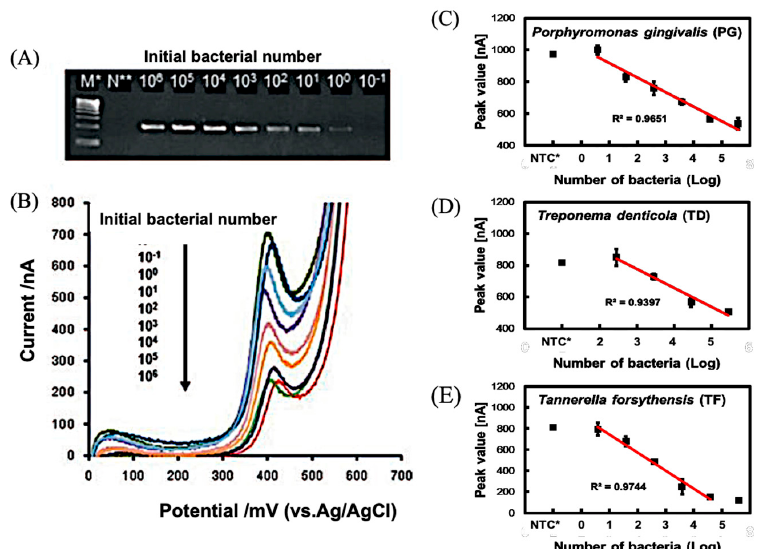
Figure 9. Electrochemical measurement of periodontal bacteria using PCR amplification [15]. ( A ) Electrophoresis of PCR-amplified genes encoding PG bactetium. Initial bacterial number (10 1 –10 5 ), M* (molecular weight marker) and N* (negative control) were indicated. ( B ) Cyclic voltammograms(0–700 mV) were obtained with PCR amplified genes with different initial bacterial number. Calibration for number of bacteria of PG ( C ), TD ( D ) and TF ( E ).